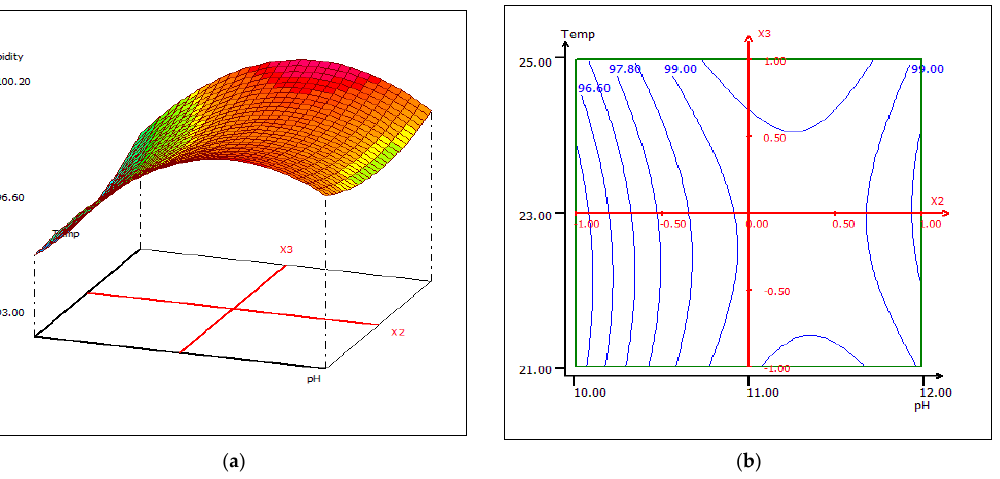
Figure 18. Three-dimensional ( a ) and two-dimensional ( b ) response surface plots for the turbidity of the treated food wastewater using β-chitin extract as a function of temperature and pH, when the coagulant dose was maintained at 10 mL.